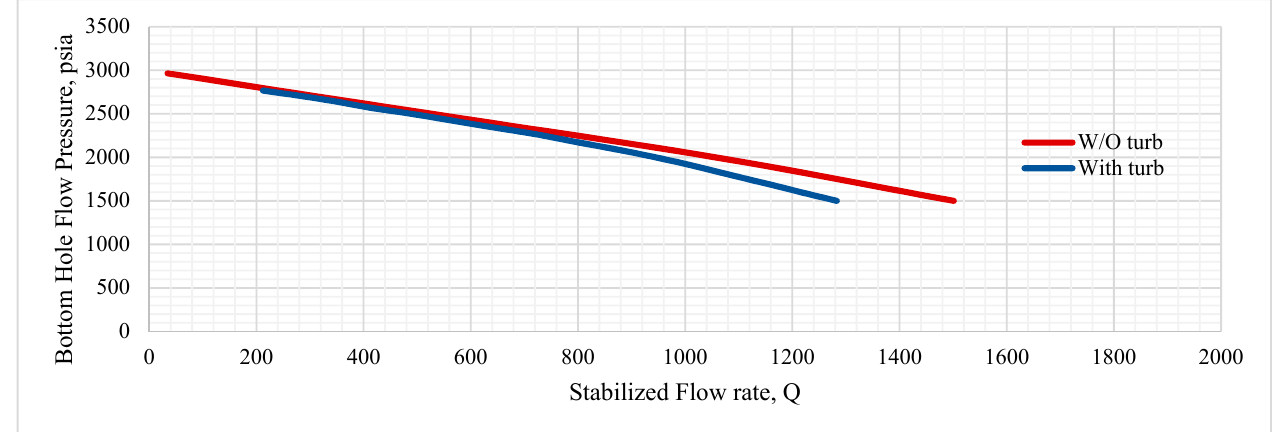
Figure 13. Inflow performance relationship.